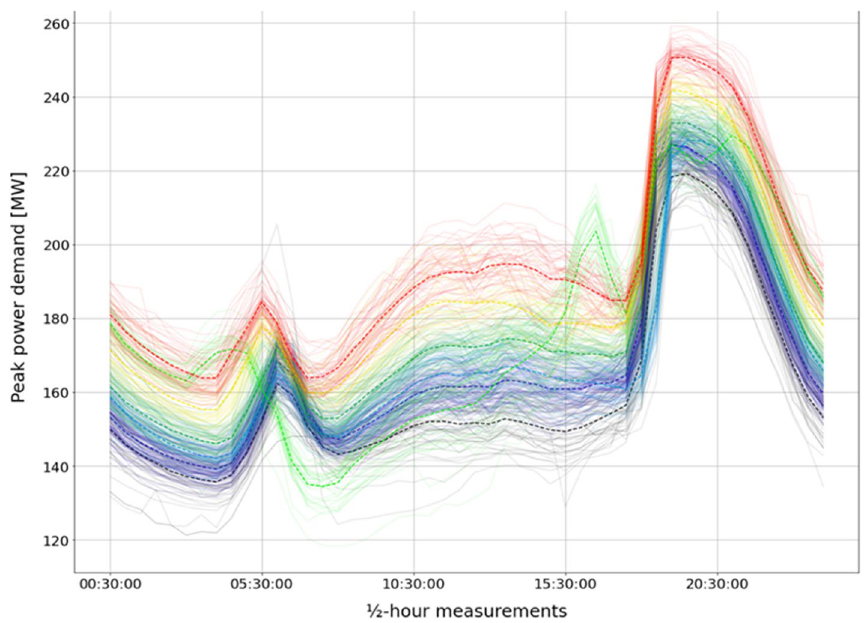
Fig. 15 Seven clusters for Lombok electricity consumption in 2019